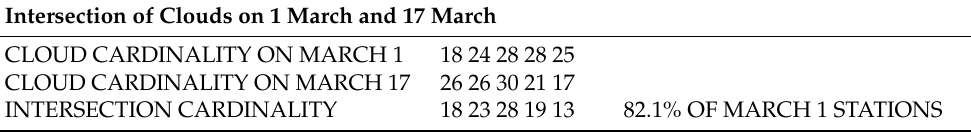
Table 1. A sample of cardinality of subsets and intersection resulting in subset c k (copied from Table